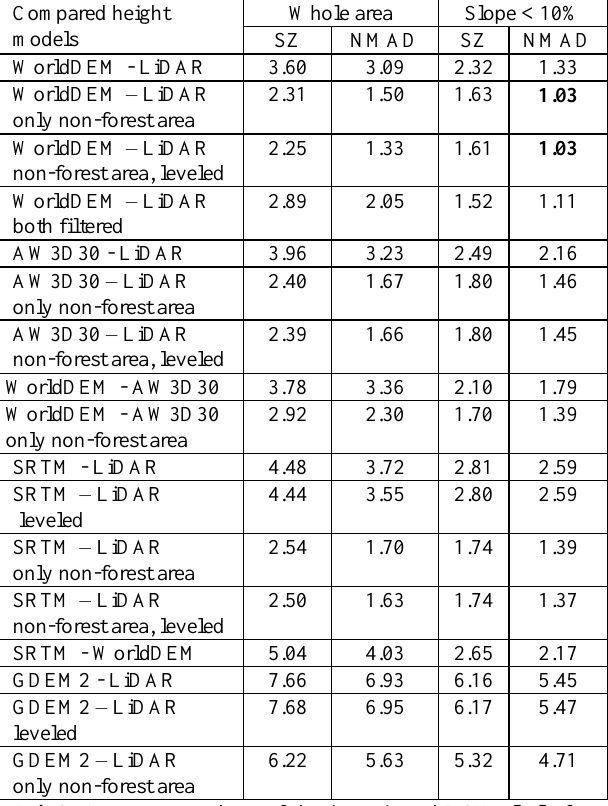
Tab.3: Accuracy numbers of the investigated DSM [m] after shifting in X, Y, Z (see table